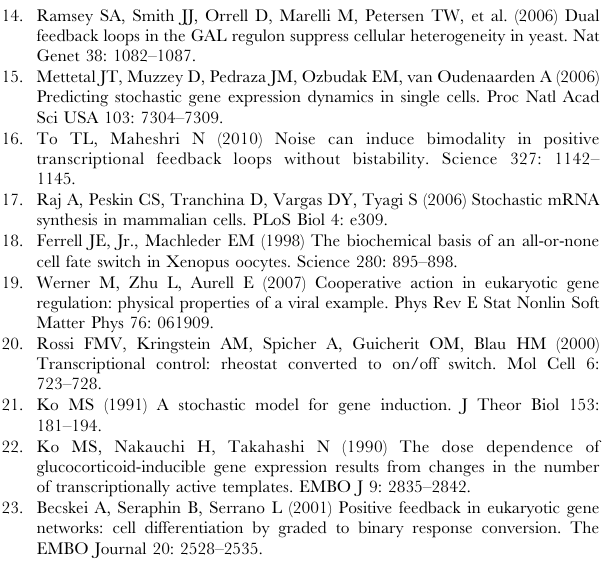
Figure S1 Construction and stochastic simulation for 2- state MCM of repressor alone and activator alone. (a) Two 2-state MCMs. One is the gene induction for activator only by switching forth and back between activator-bound and unbound states; the other is for repressor only with forward and reverse transitions between repressor-bound and unbound states. The red rectangle is the repressor and green oval is the activator.